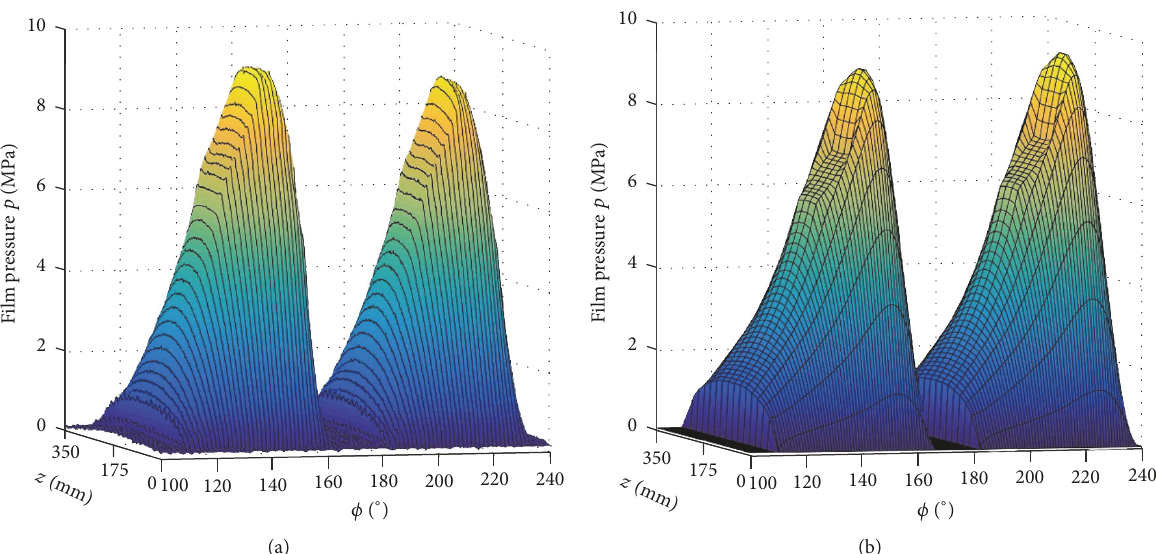
Figure 9: Measured [5, 6] and predicted pressure distribution on the loaded pads 3 and 4 (TPB500, 𝑛 = 3000 min −1 , 𝑝 𝑞 = 2.0 MPa, 𝑄 = ∘ 420 l/min, and 𝑇 sup = 50